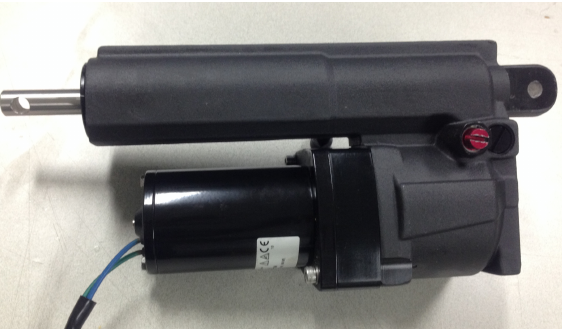
Figure 1. Commercial C-EHA made by Parker Hannifin company (Cleveland, OH, USA). (EHA